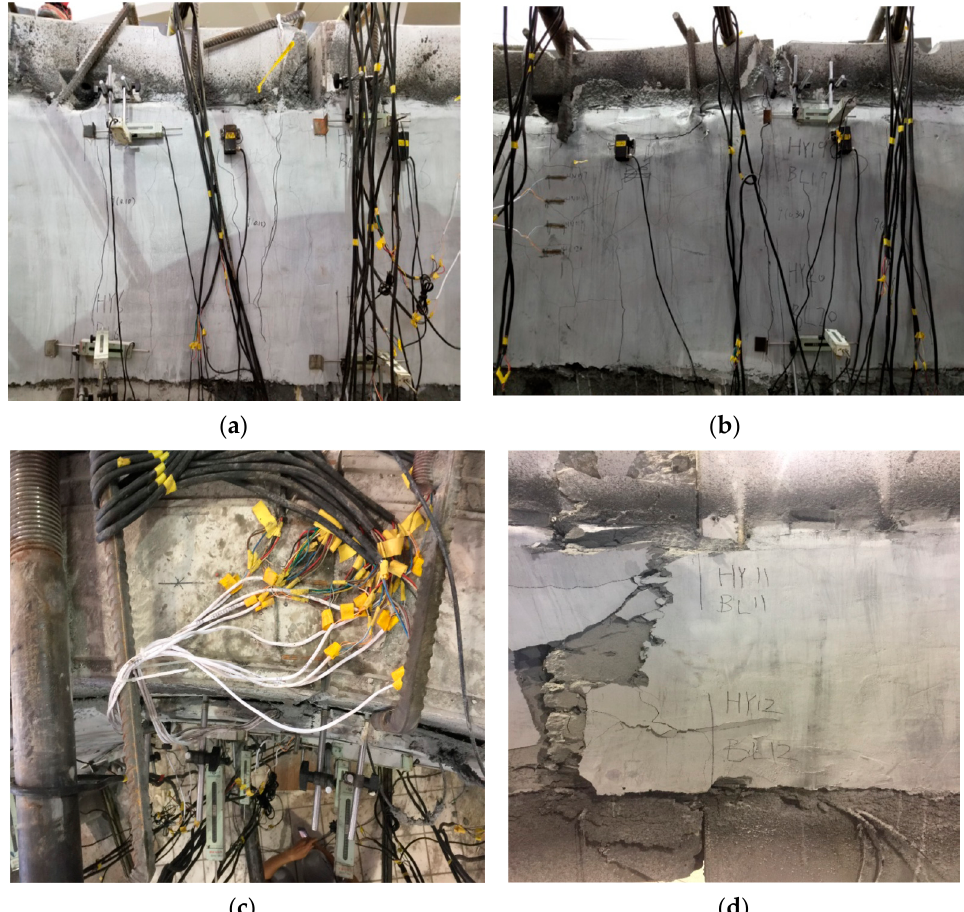
Figure 14. Failure of strengthened segment under load; ( a ) cracks near 342° inner arc surface; ( b ) cracks near 126° inner arc surface; ( c ) interface stripping at 277.5°; ( d ) mortar layer broken.